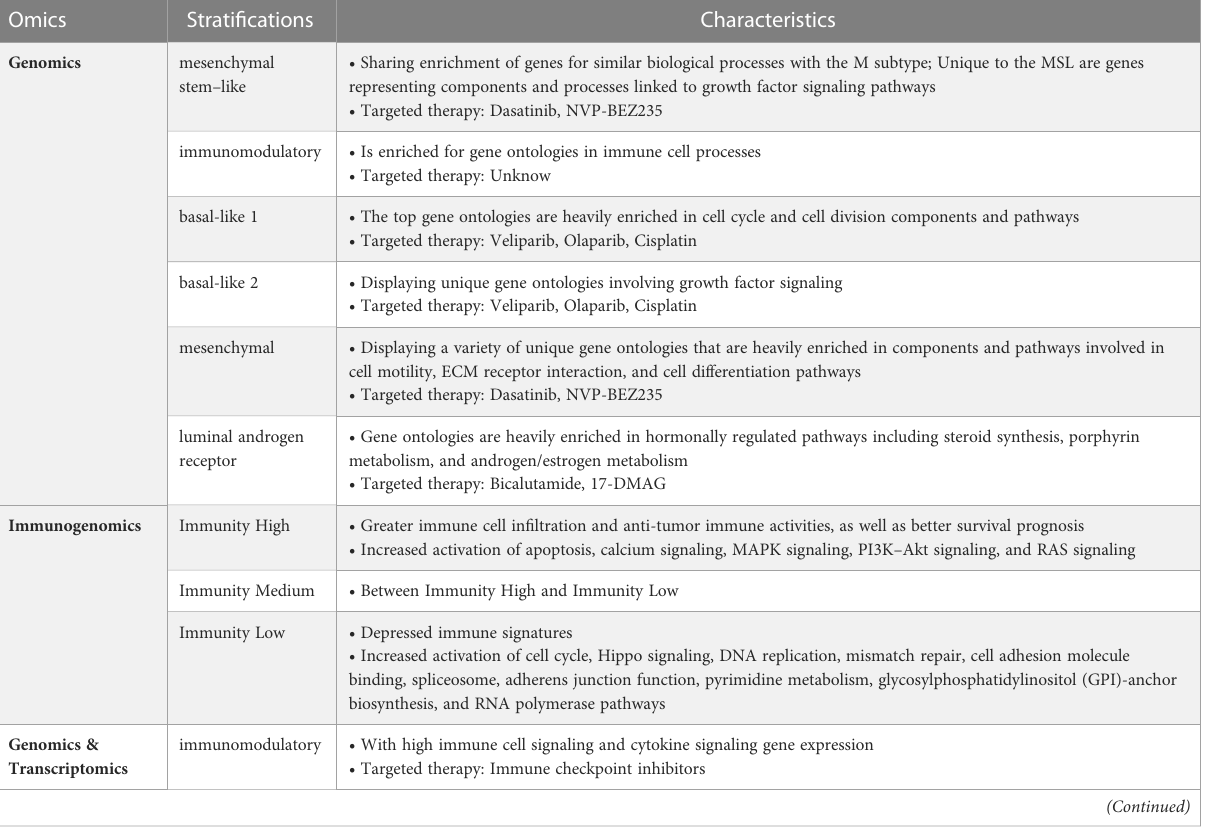
TABLE 1 TNBC strati fi cation schemes based on different omics. Omics Strati fi